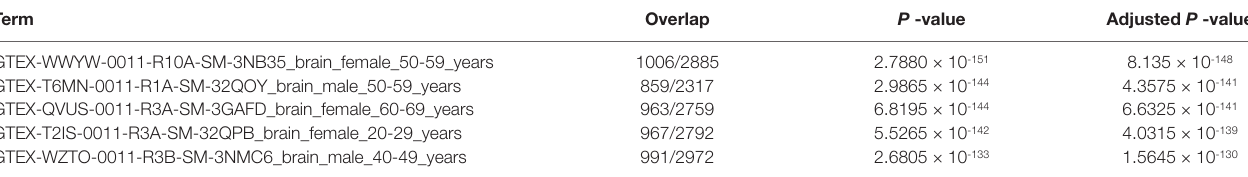
TABLE 12 | Five top-ranked terms from “GTEx Tissue Sample Gene Expression Profiles up” by Enrichr for 3,324 genes selected commonly between samples without and with stress. Term Overlap